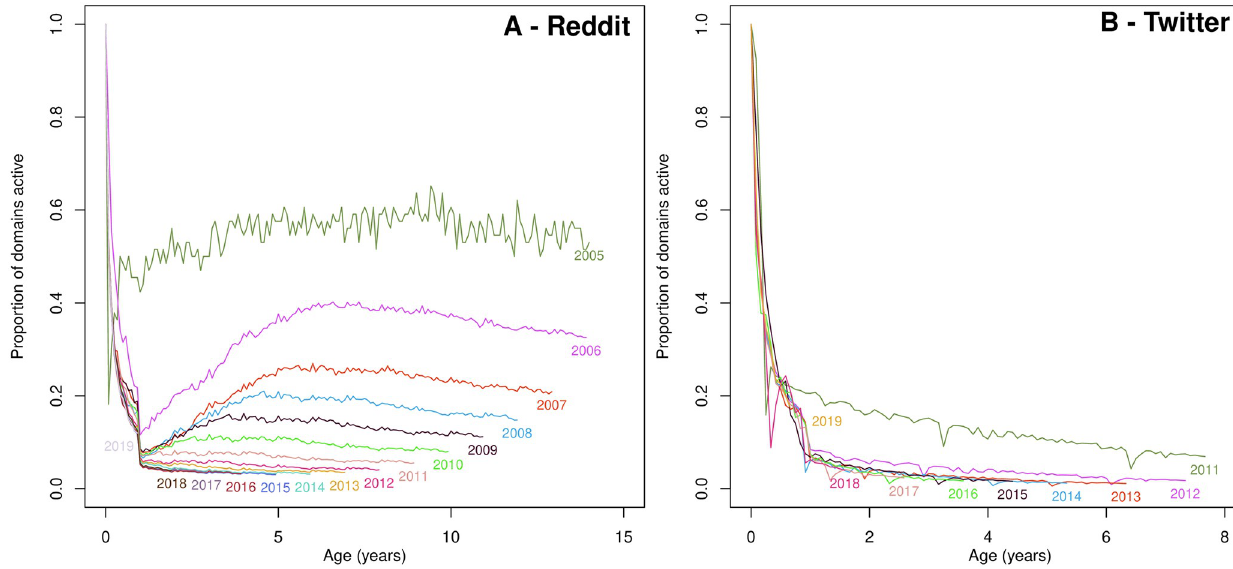
Fig 6. Survival rates of newborn online services are in decline in both Reddit (A) and Twitter (B). Lines show survival rates for the cohort of all new domains sorted by year of first appearance. The percentage still active 5 years after their first appearance from that birth year is in steady decline. Survival may increase after year